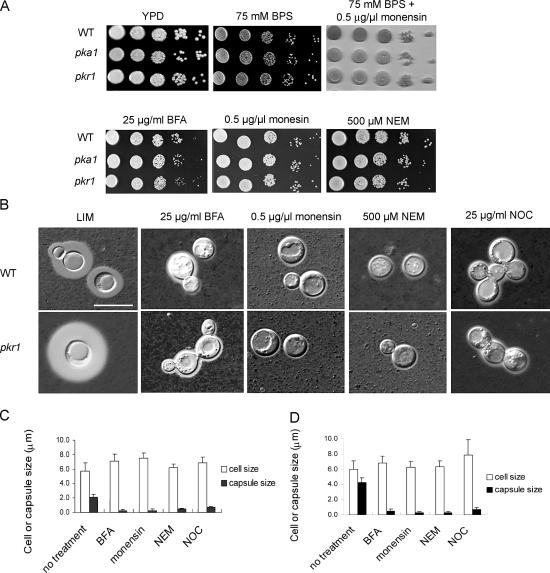
Suppression of Capsule Formation by Secretion Inhibitors(A) Sensitivity of the WT strain H99 and the pka1 and pkr1 mutants to trafficking inhibitors. Photographs of cells on medium containing the ferrous iron chelator BPS, and the chelator plus monensin, are included to demonstrate growth of the strains under low iron conditions similar to those used in the broth cultures (B) to measure capsule size.(B) Suppression of capsule formation in both the WT strain and the pkr1 mutant after treatment with trafficking inhibitors at the indicated concentrations. Cells were cultured in LIM at 30 °C and examined at 72 h after addition of the inhibitors indicated. Chemicals and concentrations are indicated at the top and the strains are noted on the left of the photographs. Bar = 10 μM.(C and D) Sixty cells from the WT (H99) strain (C) and the pkr1 mutant (D) were measured to determine cell diameter and capsule radius with and without treatment with the trafficking inhibitors (as shown in [B]). The capsule sizes of the treated cells were statistically different (p <0.001) from the sizes for the untreated cells in all cases. Each bar represents the average of 60 measurements.